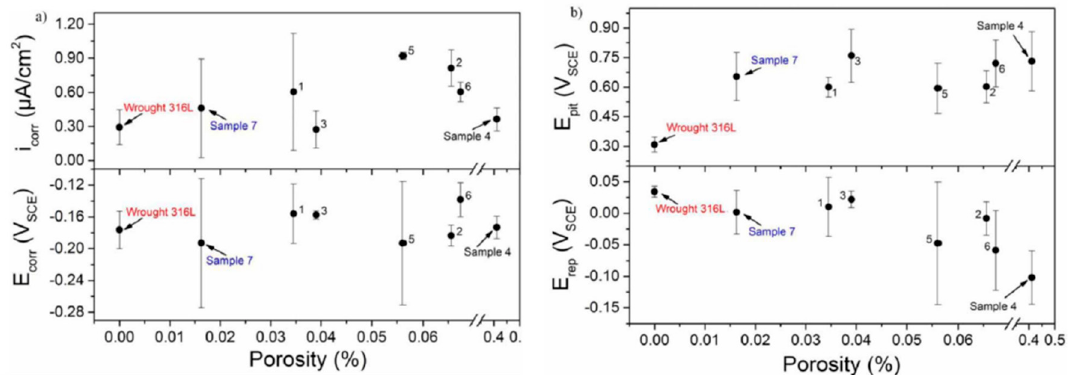
Figure 2. ( a ) E corr , and i corr , and ( b ) E pit and E rep values of the SLM 316L samples plotted against the porosity of the samples [15].